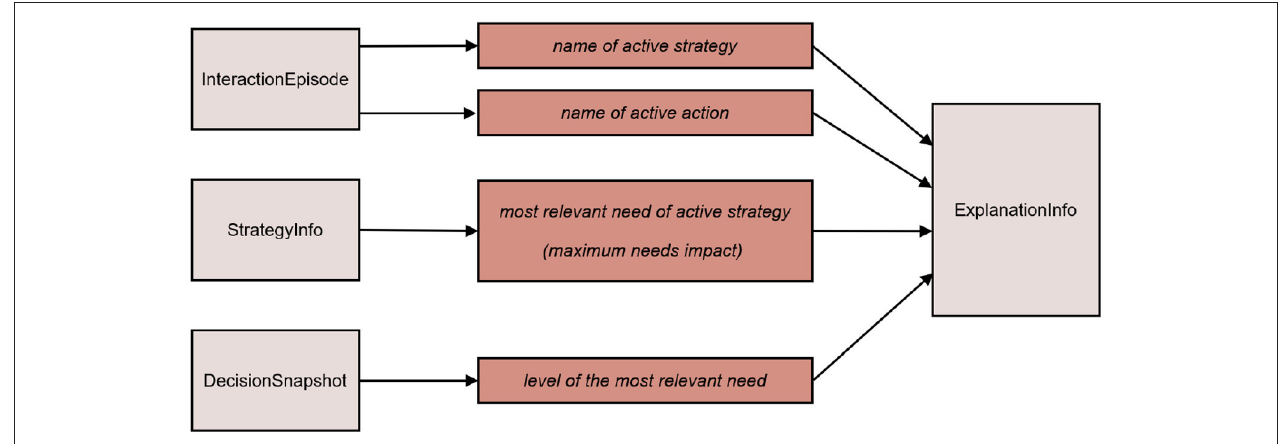
FIGURE 7 | The content of ExplanationInfo (middle column) and the source messages from which the relevant information are extracted (right column).